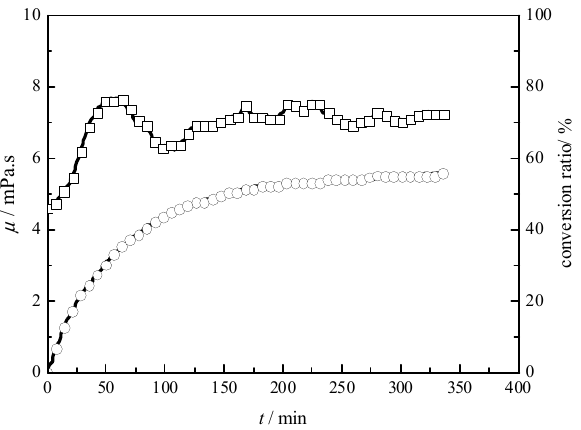
Figure 7. Typical trend of ( □ ) viscosity and ( ○ ) conversion ratio variations with time during hydrate formation at 278.2 K, with an initial pressure of 6.0 MPa and stirring speed of 300 rpm for 10% water cut system with AA-2. Lines are provided to guide the eye.